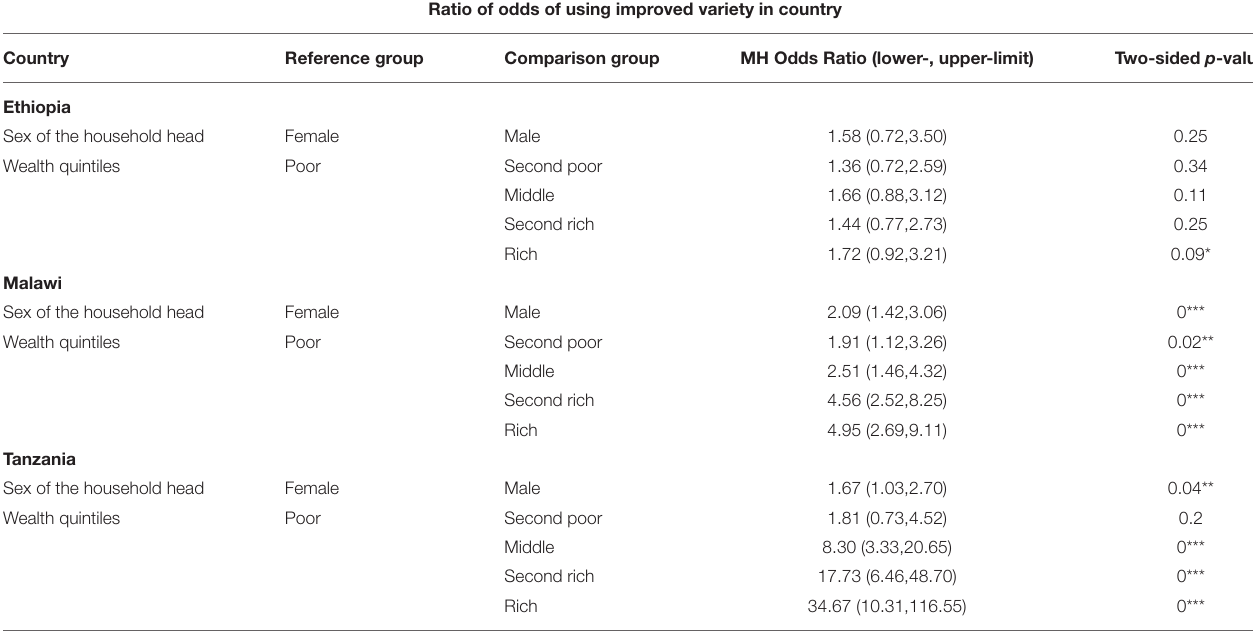
TABLE 4 | Wealth ranking and maize variety use at the study sites in Ethiopia, Malawi and Tanzania. Ratio of odds of using improved variety in country Country Reference group Comparison